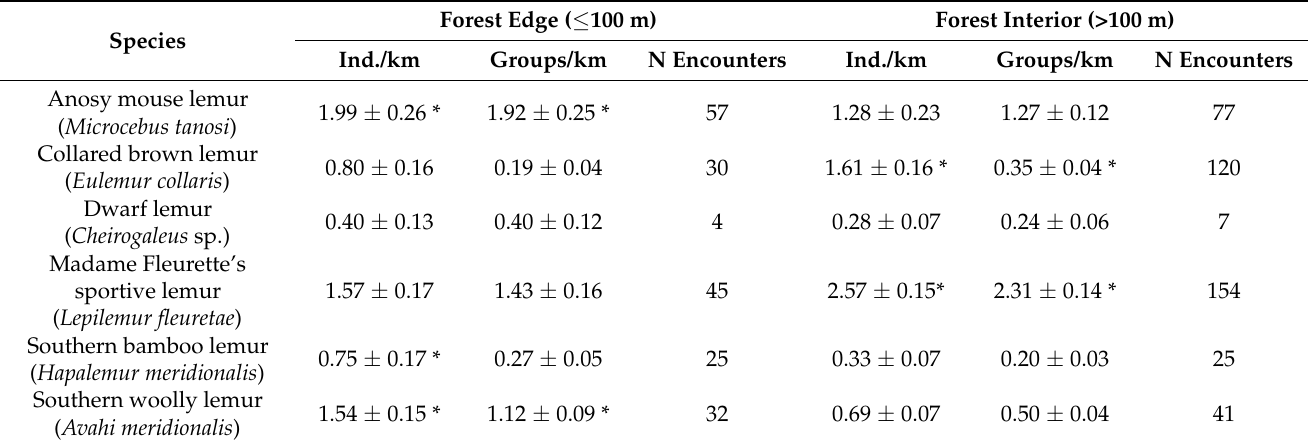
Table 3. Encounter rates of individuals and groups, and total times individuals were encountered in 11 transects of forest edge and 10 transects of forest interior. The total distance walked at edge transects was 37.4 km for cathemeral lemurs, 28.6 km for nocturnal lemurs, 10.0 km for dwarf lemur. The total distance walked at interior transects was 74.8 for cathemeral lemurs, 59.9 km for nocturnal lemurs, 25.0 km for dwarf lemur. We compared the values between edge and interior transects via Generalised Linear Models (Tweedie distribution). Values are estimated model means and